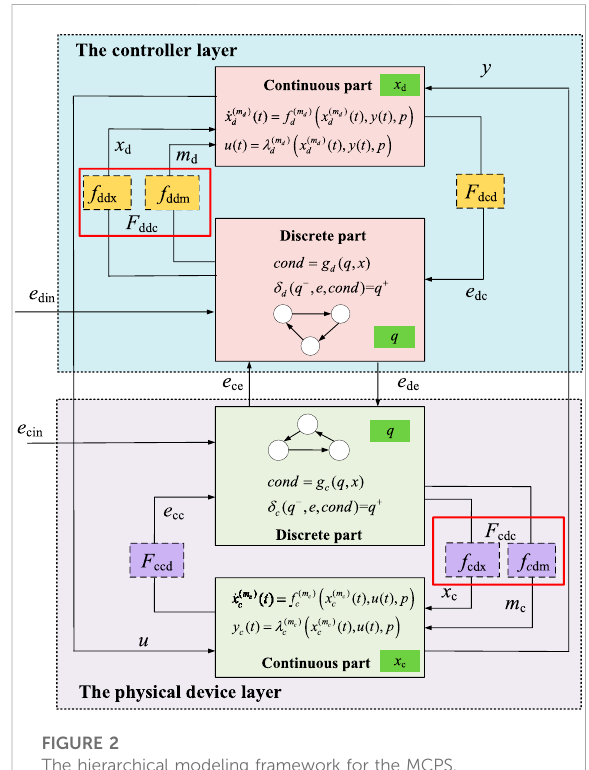
FIGURE 2 The hierarchical modeling framework for the